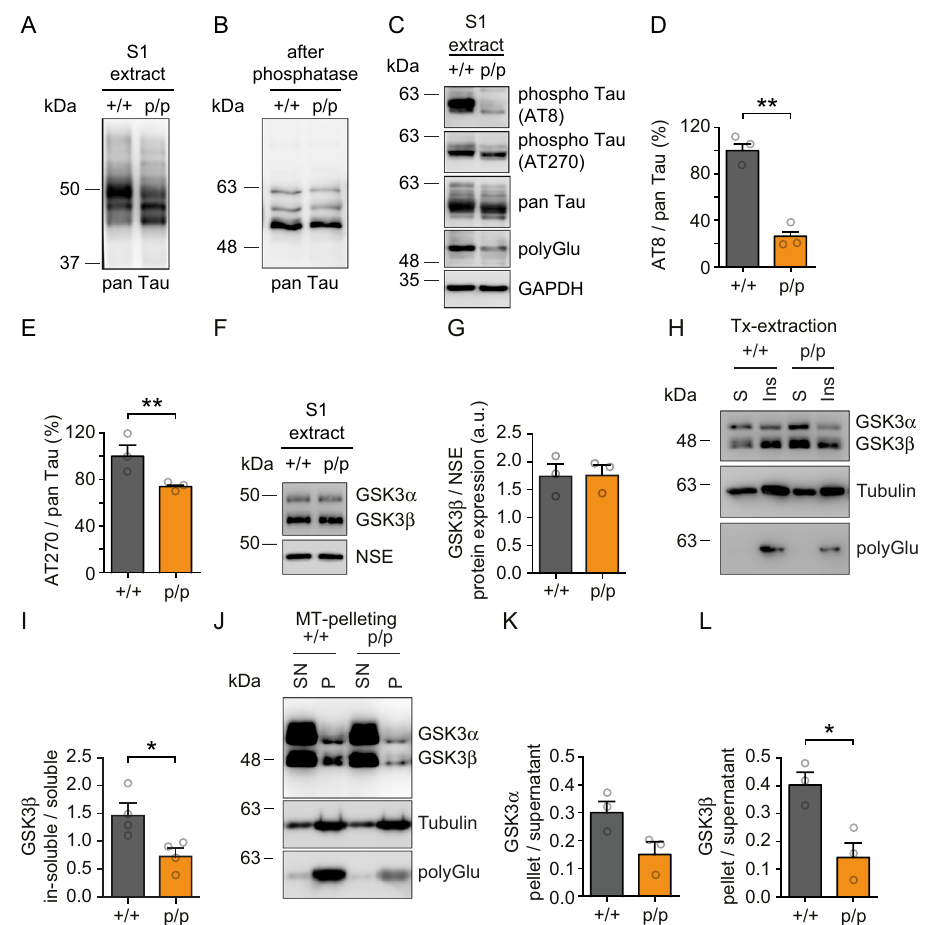
Fig. 5 Loss of Tuba4a C-terminal polyglutamylation signi fi cantly decreases phosphorylation of mouse Tau and binding of GSK3 β to microtubules. A Representative western blot analysis of pan Tau in hippocampal lysates (S1 extract) from adult Tuba4a Δ polyGlu ( + / + ) and (p/p) mice. B Representative western blot analysis of pan Tau in hippocampal lysates (S1 extract) after phosphatase treatment from adult mice. C Western blot analysis of Tau phosphorylation in hippocampal lysates (S1 extract) from adult mice. AT8 and AT270: phosphorylated Tau-speci fi c antibodies. pan-Tau: total-Tau. polyGlu: polyglutamylated tubulin. GAPDH: loading control. The representative western blots shown in ( A – C ) are derived from three independent experiments. D – E Quanti fi cation of relative AT8 ( D ) and AT270 ( E ) signal intensities normalized to total Tau. ( + / + ) set to 100%. n = 3 experiments per genotype. F Western blot analysis of GSK3 α / β in hippocampal lysates (S1 extract) from adult mice. NSE: loading controls. G Quanti fi cation of GSK3 β signal intensities shown in ( F ). n = 3 mice per genotype. H , I Soluble-tubulin extraction assay using DIV15 neurons derived from Tuba4a Δ polyGlu ( + / + ) and (p/p) mice. (H) Western blot. Soluble fraction (S): un-polymerized tubulin and dissociated MAPs. Insoluble fraction (Ins): polymerized tubulin (microtubules) and associated MAPs. Fractions were probed for GSK3 α / β and total alpha-tubulin and polyGlu tubulin. I Quanti fi cation of GSK3 β in- soluble/soluble levels. Ratios smaller than 1 indicate higher protein abundance in soluble fractions. n = 4 independent cultures per